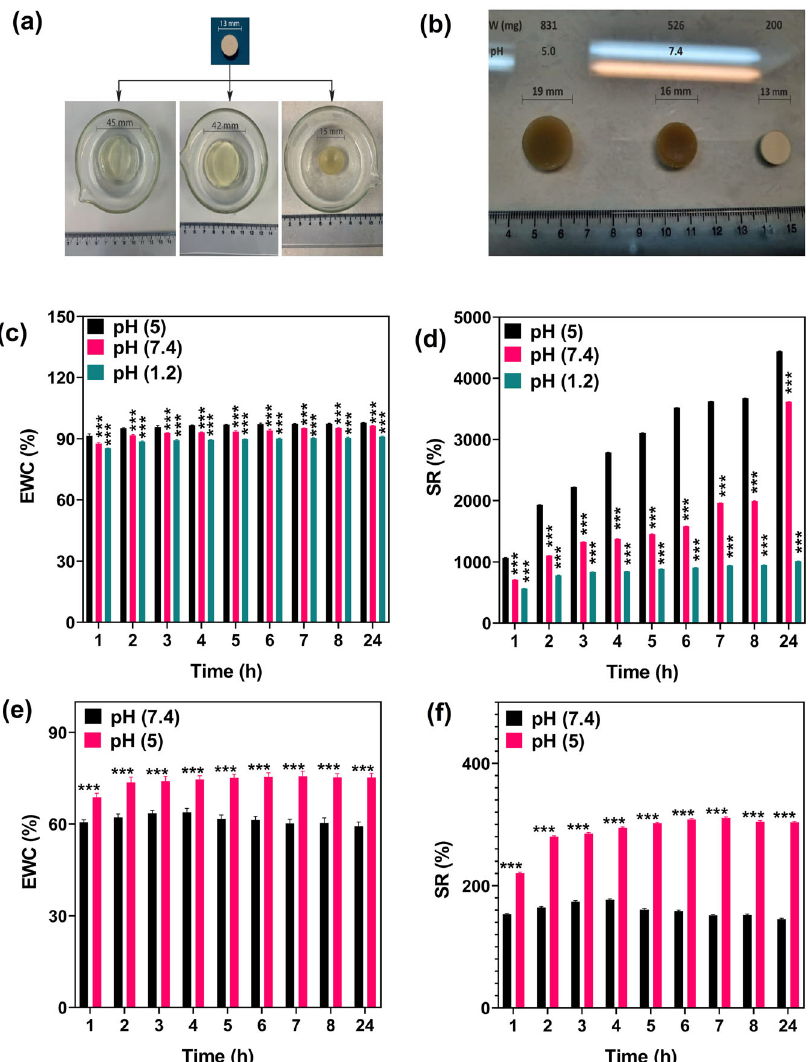
Fig. 8 The effect of pH on swelling behavior, EWC and SR of hydrogels. a CS-g-gly dry tablet in pH = 1.2, pH = 5 and pH = 7.4 after 24h, ( b ) CMCS-g-gly dry tablet in pH = 5 and pH = 7.4 after 24h, ( c ) CS-g-gly EWC (%), ( d ) CS-g-gly SR (%), ( e ) CMCS-g-gly EWC (%), ( f ) CMCS-g-gly SR (%), in different pH. Each experiment was performed and replicated three times, and the results were displayed using error bars to depict the